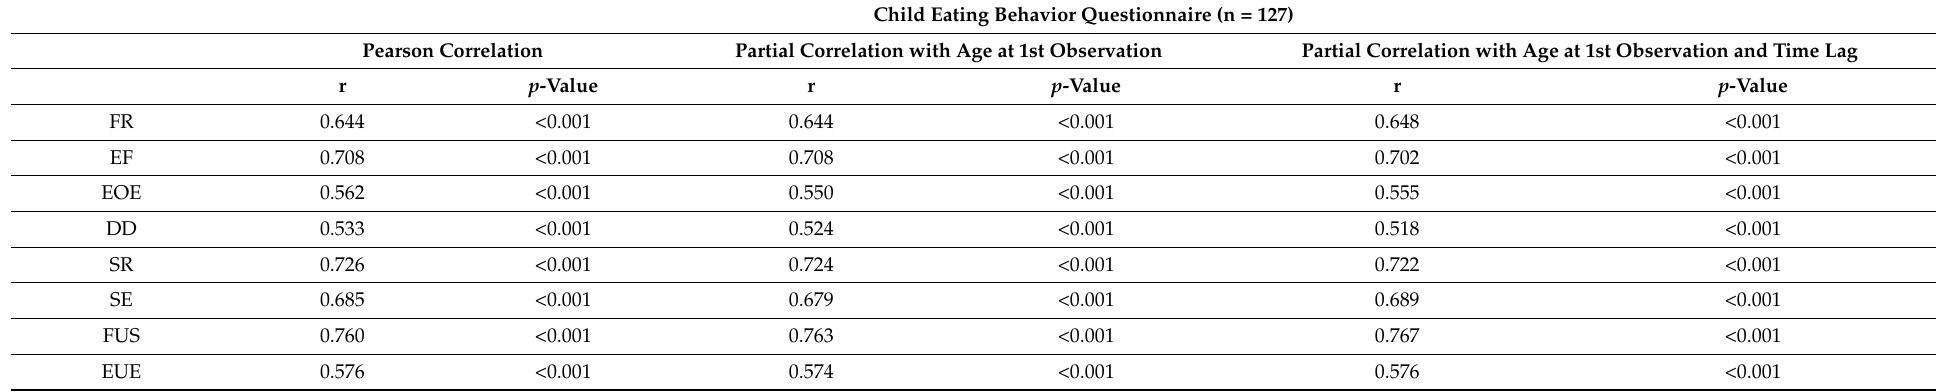
Table 4. Paired correlations between observations 1 and 2 to determine tracking within individuals for Child Eating Behavior Questionnaire subscales. Child Eating Behavior Questionnaire (n =